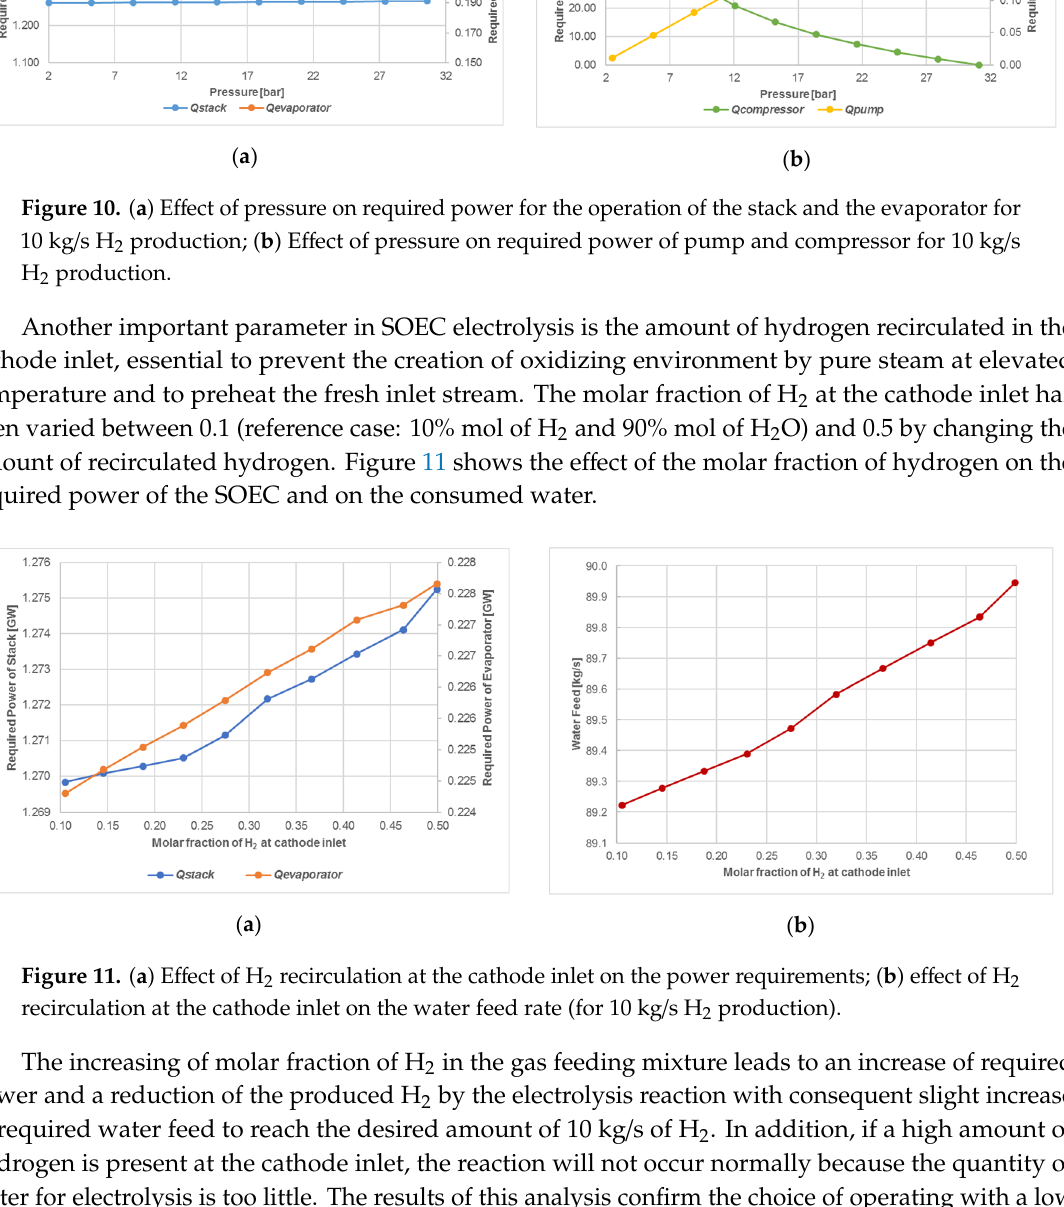
( b ) Figure 12. ( a ) Effect of steam/biomass ratio and gasifier temperature on the water free composition of the produced syngas; ( b ) effect of gasifier temperature on the water free composition of the produced syngas. The increase of steam/biomass ratio leads to an increase of the H 2 and CO 2 yields in the syngas at the expense of CO and CH 4 . Instead, the temperature does not significantly affect the H 2 amount in the produced syngas but increases the amount of carbon monoxide with a linear behavior. Therefore, a good compromise should be achieved, according to the availability of steam, on the cost related to its production and to the separation of produced hydrogen and the reduction of carbon dioxide. 4.2. Integration of Hydrogen in Methanol and Methane Synthesis Hydrogen intensified methane and methanol syntheses in the steel industry has been studied by coupling the hydrogen models with methane and methanol production ones by considering two